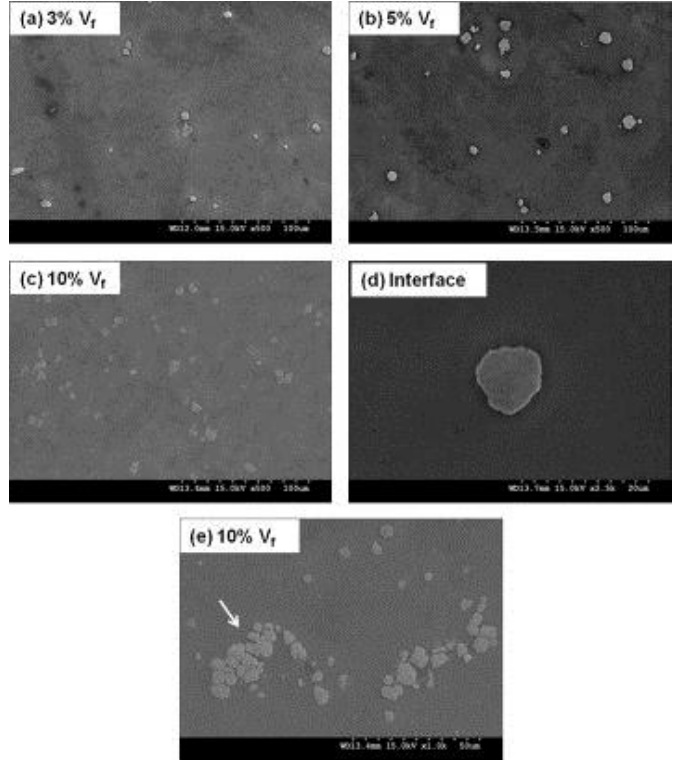
Figure 13. SEM images showing the distribution of Ni 60 Nb 40 amorphous particles in Mg matrix composites. White arrow in (e) represents clustering of particles. (reprinted from Jayalakshmi et al . 2014 [16], with permission from ©